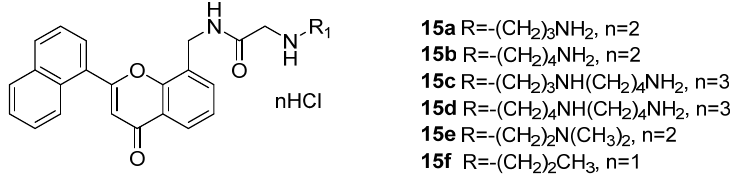
Figure 13. Chemical structures of the flavonoid polyamine conjugates, 15a – 15f [77].